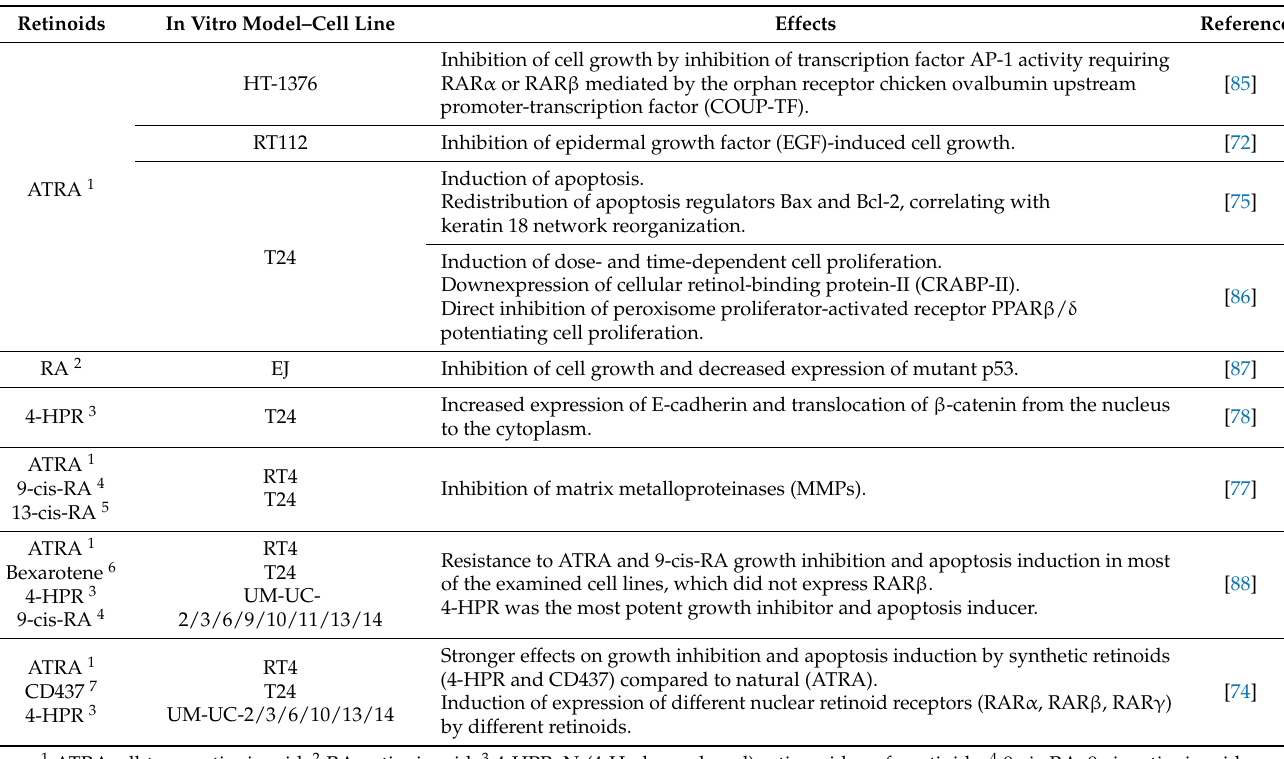
Table 1. In vitro studies investigating the effects of retinoids in human BC cell lines. Retinoids In Vitro Model–Cell Line